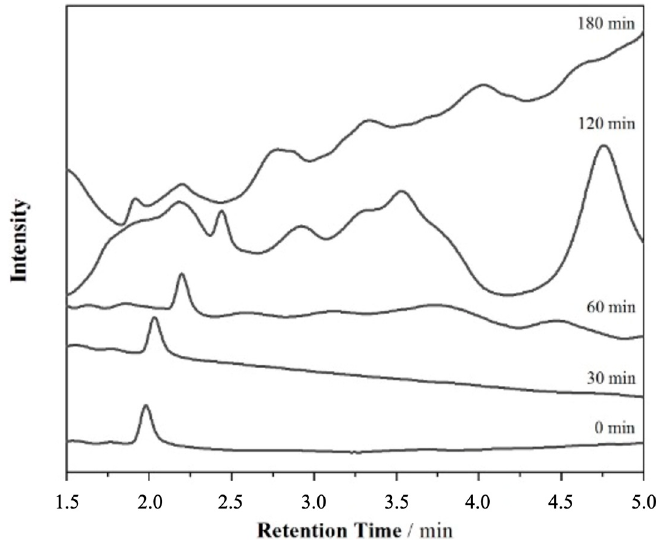
Figure 2. Chromatograms obtained by HPLC-UV indicating the degradation of chlorimuron-ethyl (initial retention time = 1.98 min) during the electroflotation test treatment of A3 at the retention times of 0, 30, 60, 120, and 180 min of reaction.